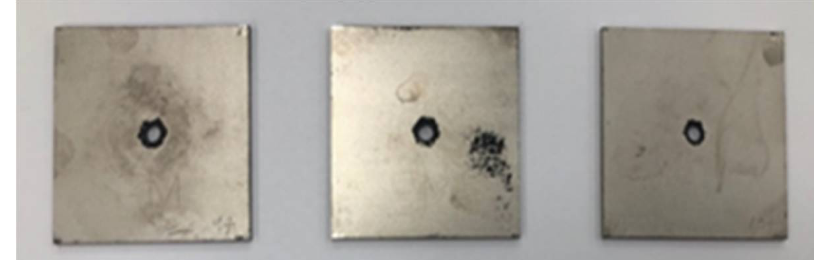
Figure 8. Specimens after the mock-up test.